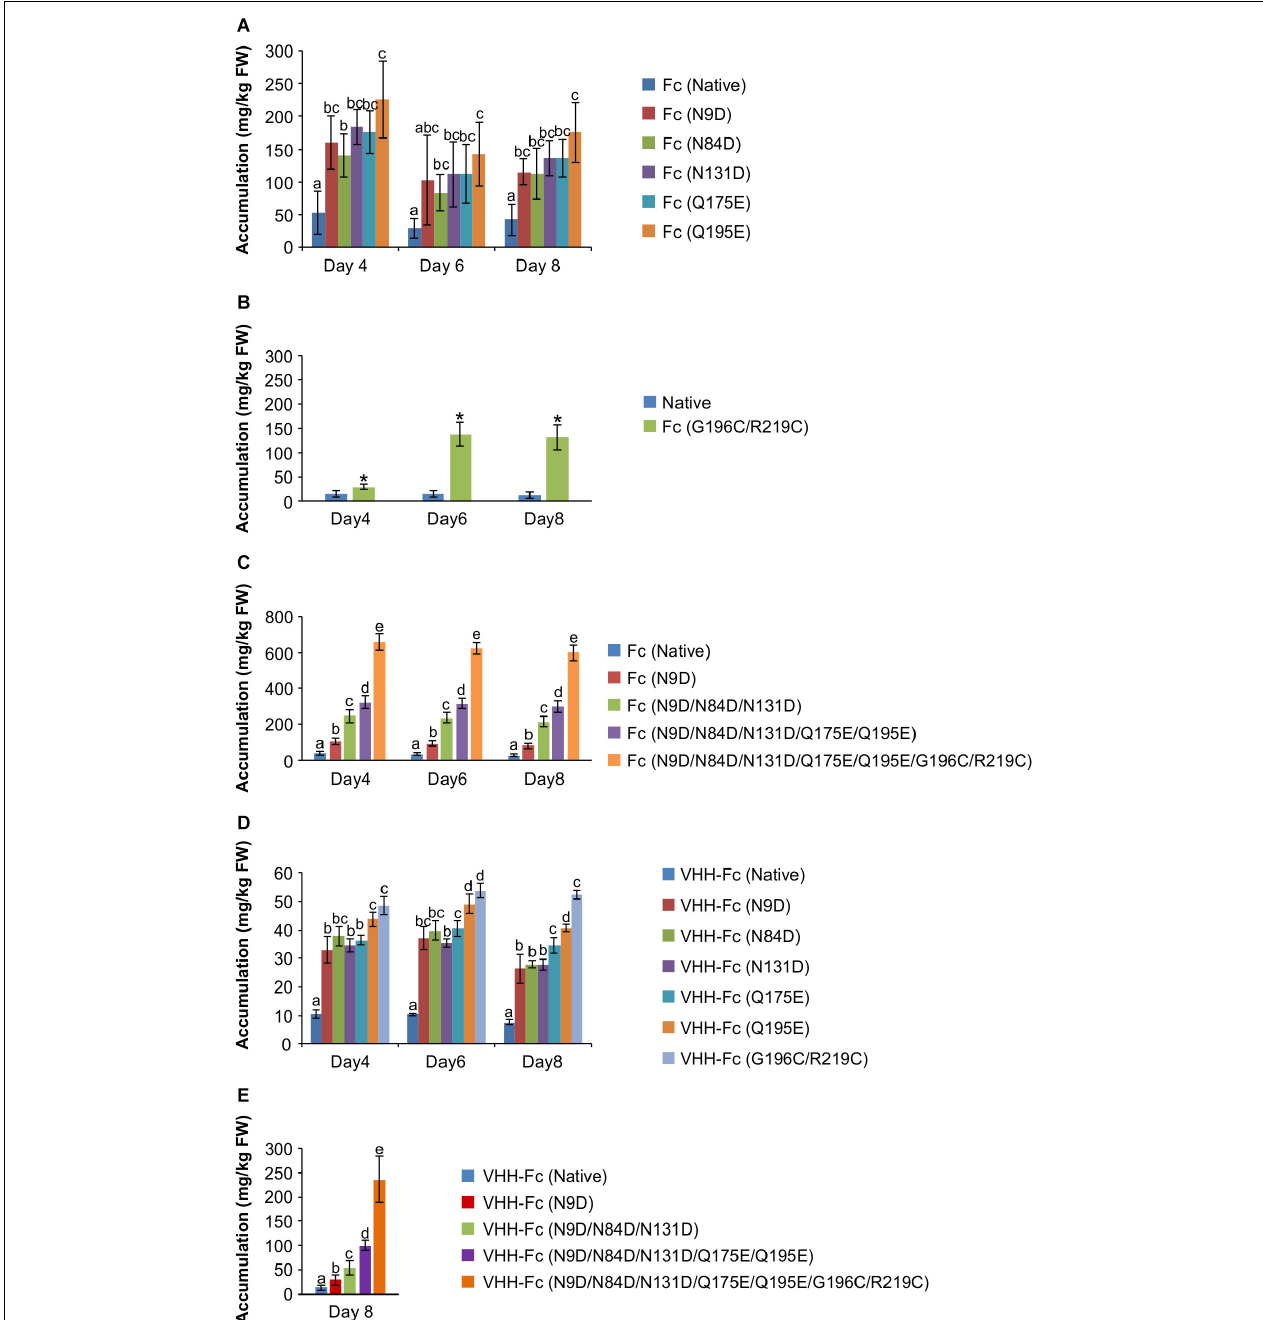
FIGURE 2 | Time courses showing accumulation after transient transformation of N. benthamiana by agroinfiltration. Shown are (A) Supercharging mutations on the Fc chain. (B) Novel disulfides on the Fc chain (C) Combining of mutations on the Fc (D) Fc with individual mutations fused to a V H H (E) Fc with combined mutations fused to a V H H on 8 dpi. * represents statistically significant difference from native as determined by a T -test. Letters denote significantly different treatments as determined by one way ANOVA and post hoc Tukey HSD test. P < 0.05, n = 3-5 biological replicates. Error bars shown are standard error of the